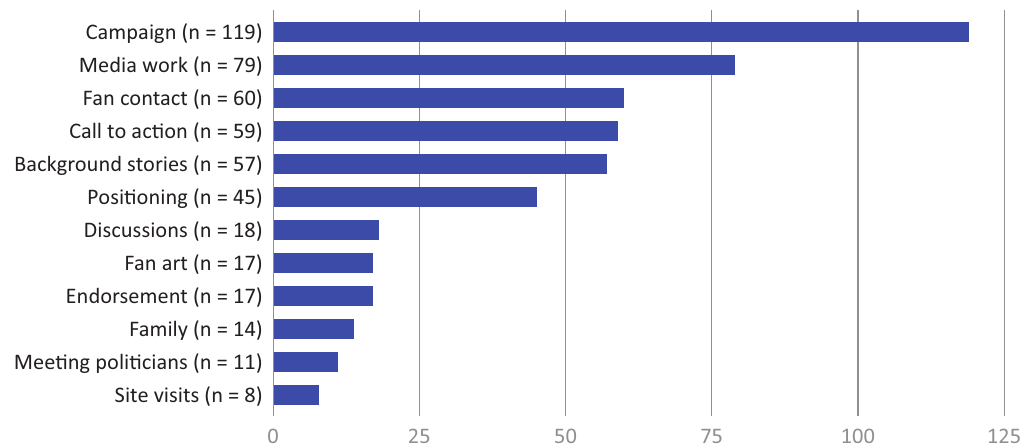
Figure 2. Quantification of image types on Alexander Van der Bellen’s Instagram account. are studio settings, the presence of cameras and micro- phones, and talks with journalists. This image type sug- gested an ongoing media interest throughout the whole campaign